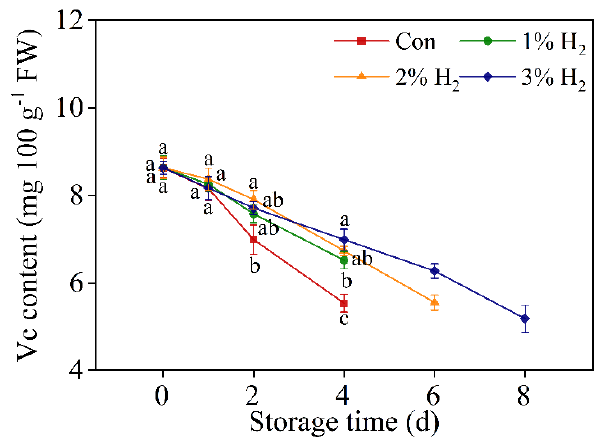
Figure 3. Time-dependent changes of vitamin C contents in response to molecular hydrogen. Chinese chive was stored at 4 ± 1 °C. Means ± SE ( n = 3) followed by different letters for each storage time indicate a statistical difference at p < 0.05.